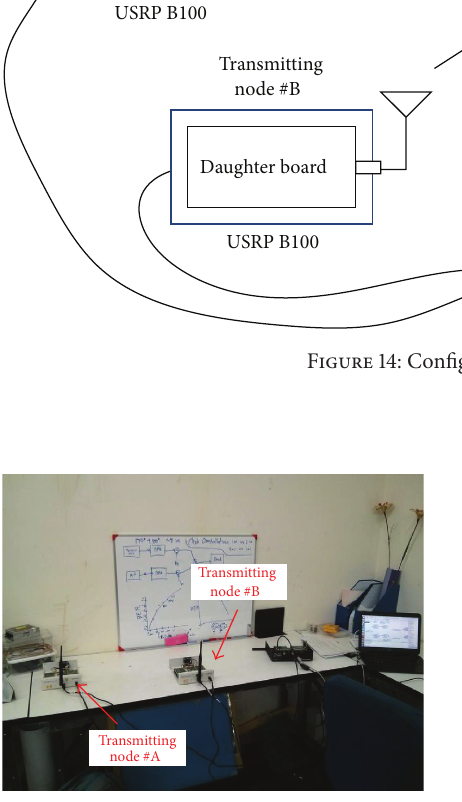
Figure 15: Two transmitting nodes employing USRP